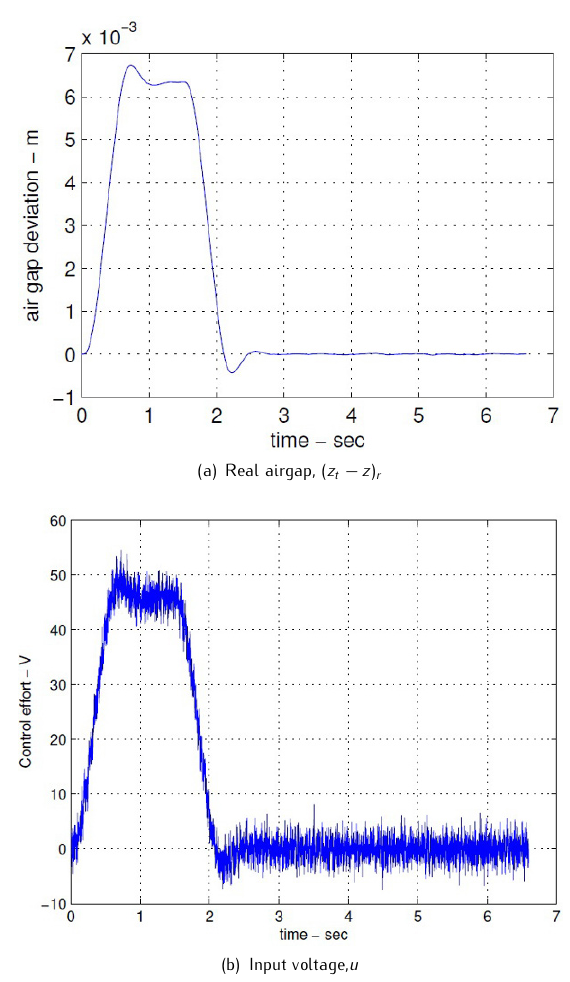
Figure 8. Pareto front of controllers using NSGAII.